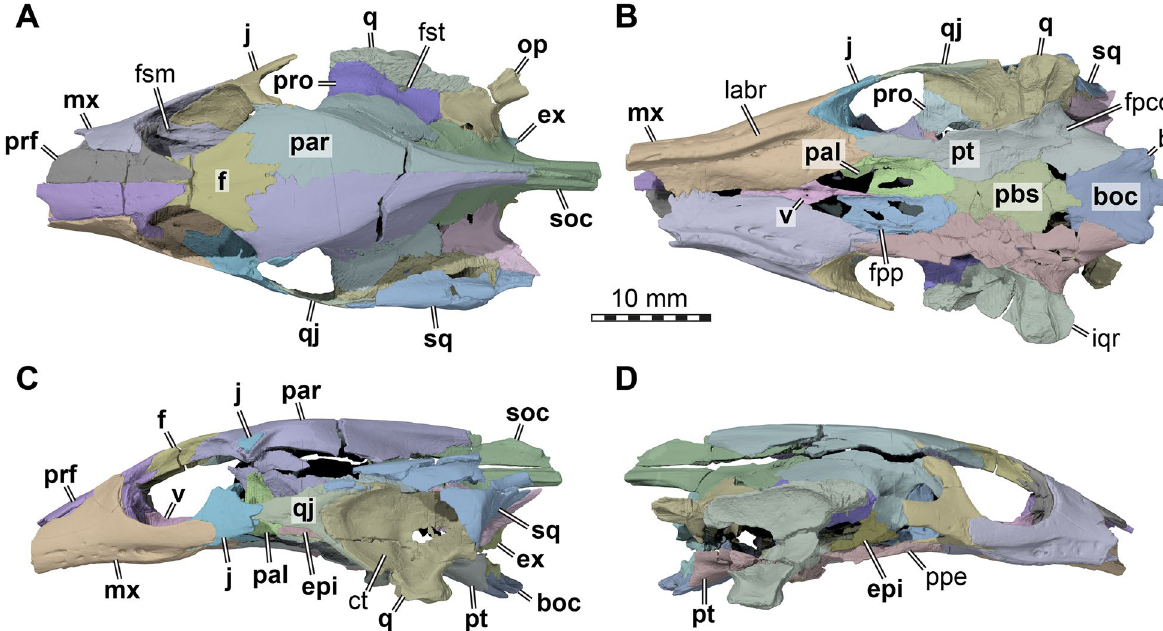
Fig. 3 Three dimensional renderings of the cranium of Plastomenus thomasii (AMNH FR 6015). A dorsal view; B ventral view; C left lateral view; D right lateral view. Note that bones are labelled in bold. boc basioccipital, bt basi tuber, ct cavum tympani, epi epipterygoid, ex exoccipital, f frontals (fused), fpcci foramen posterius canalis carotici interni, fpp foramen palatinum posterius, fsm foramen supramaxillare, fst foramen stapedio-temporale, iqr infolding quadrate ridge, j jugal, labr labial ridge, mx maxilla, op opisthotic, pal palatine, par parietal, pbs parabasisphenoid, ppe processus pterygoideus externus, prf prefrontal, pro prootic, pt pterygoid, q quadrate, qj quadratojugal, soc supraoccipital, sq squamosal, v